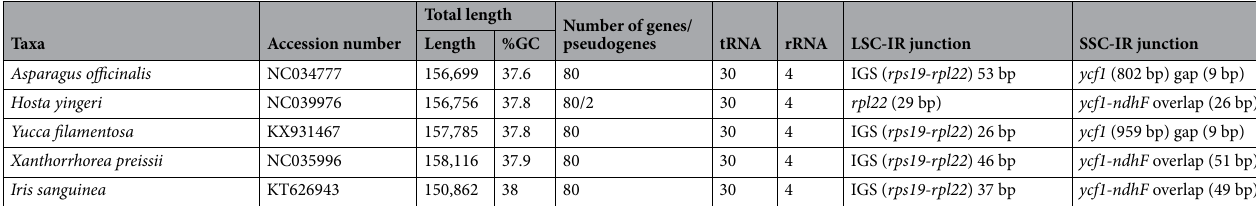
Table 1. Some features of chloroplast genomes in Allioideae and related species. a: infA loss; b: rpl22 loss; c: ndhF loss; d: ndhG loss; e: rps16 loss.